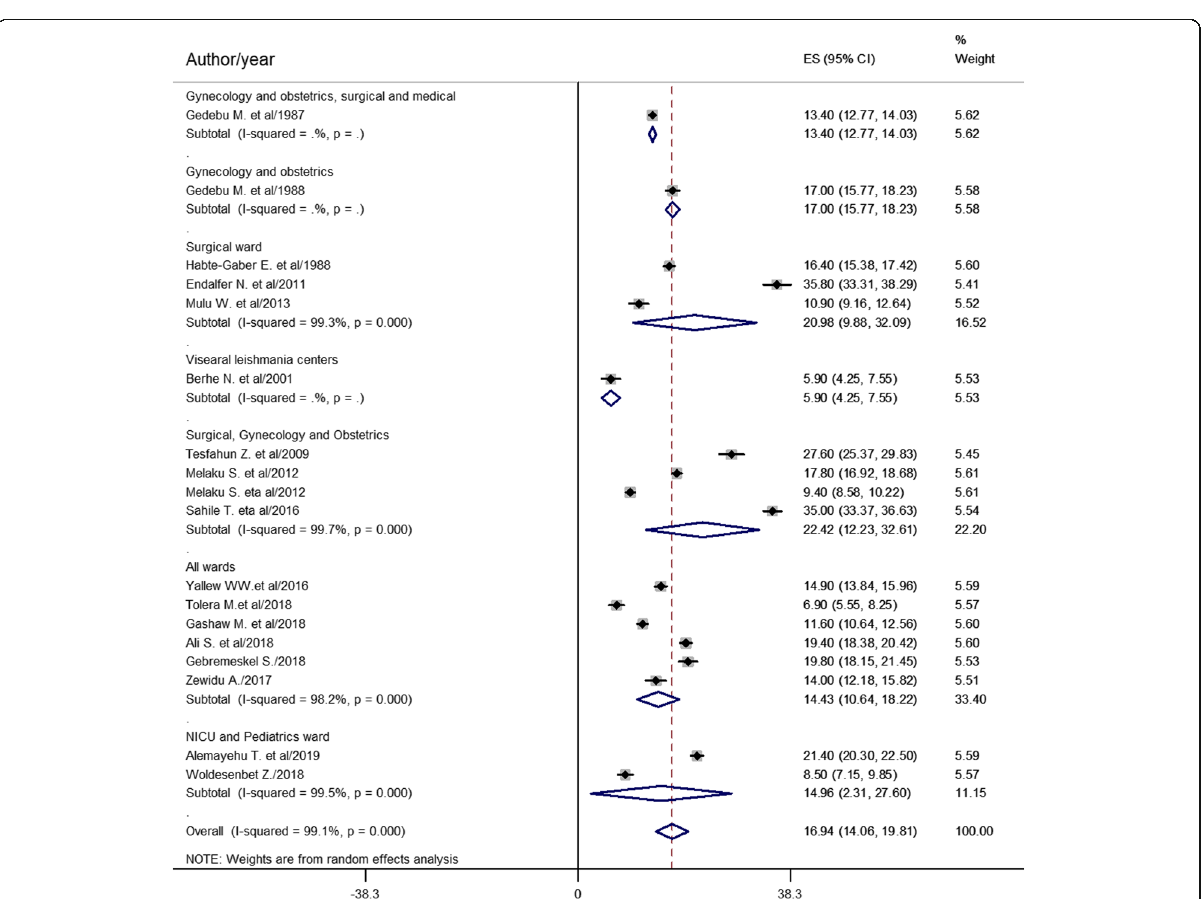
Fig. 4 Forest plot of prevalence with corresponding 95% CIs of HCAI based on ward